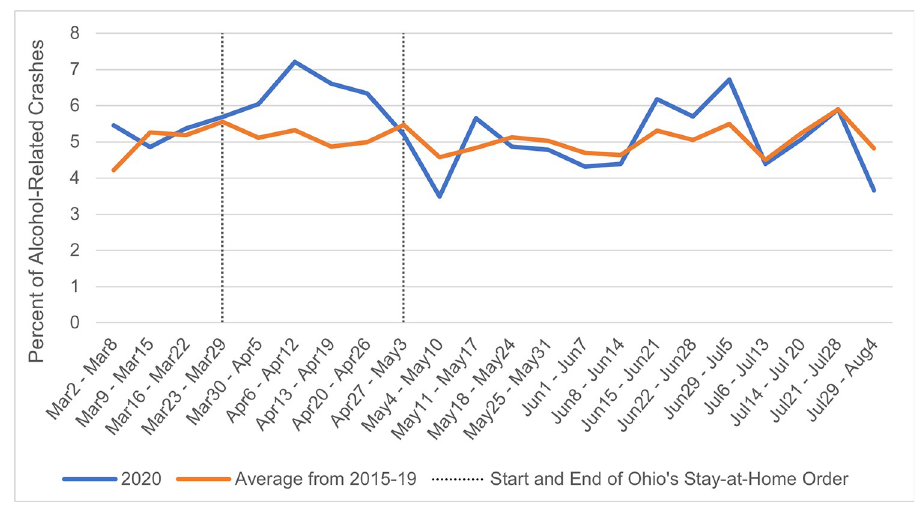
Fig 3. Proportion of alcohol-related crashes both from 2020 and the average of the years 2015 through 2019.